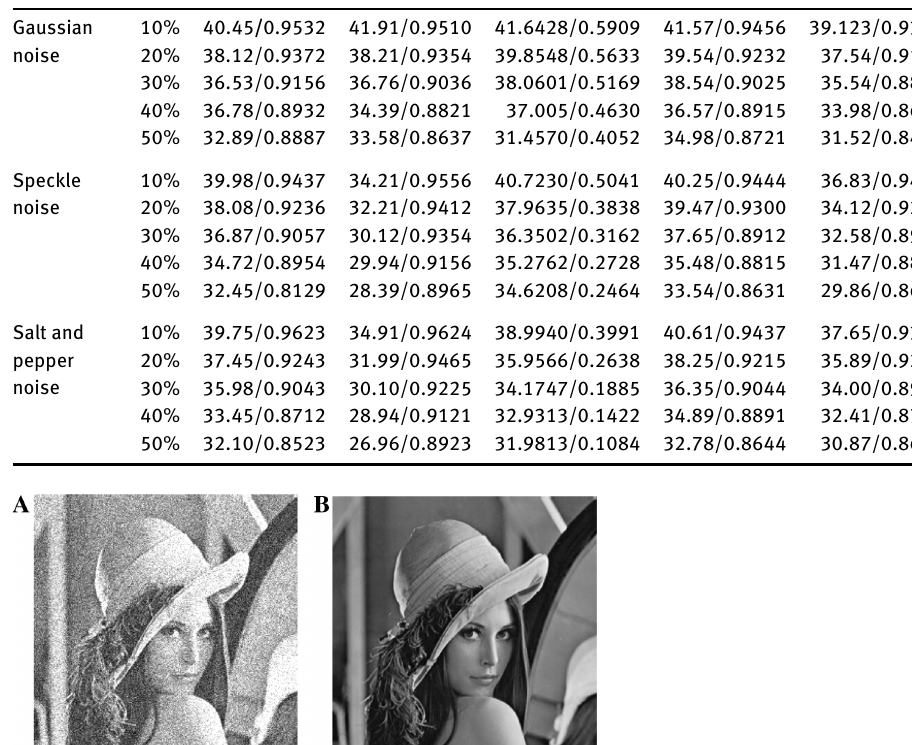
Figure 5: Analysis of Visual Quality of Restored Image (Salt and Pepper Noise in σ = 10%; PSNR = 39.75 dB, SSIM = 0.9234). (A) Input image, (B) restored